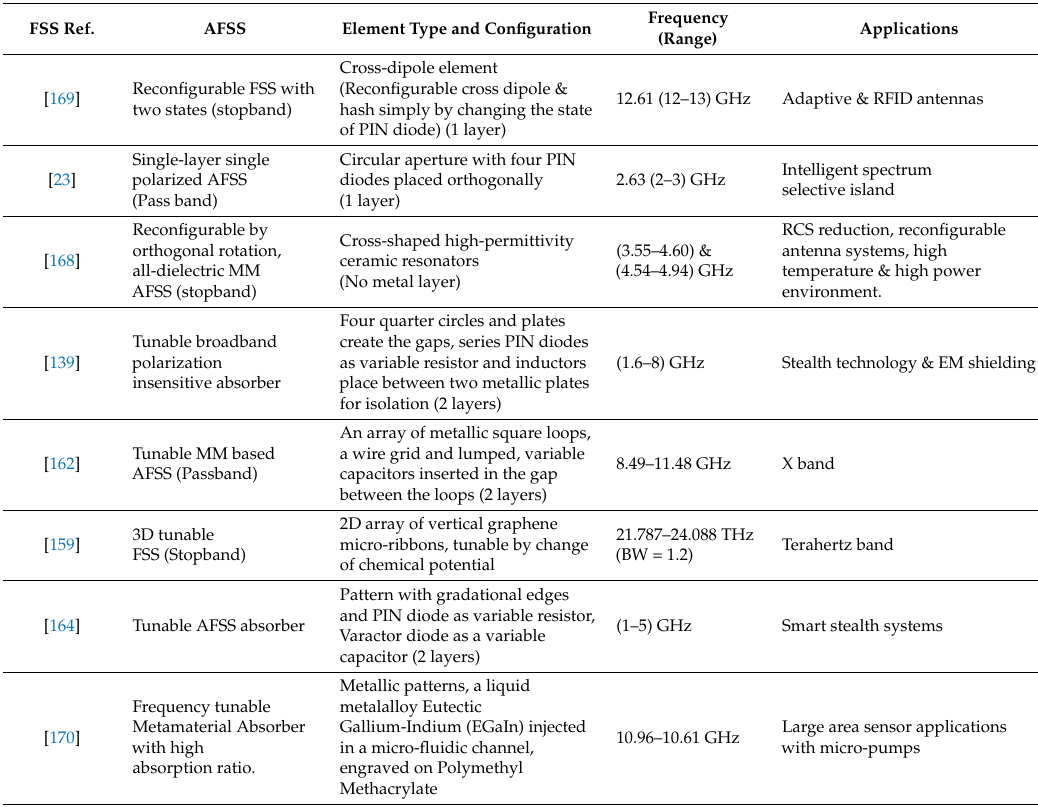
Table 8. An overview of AFSS with their